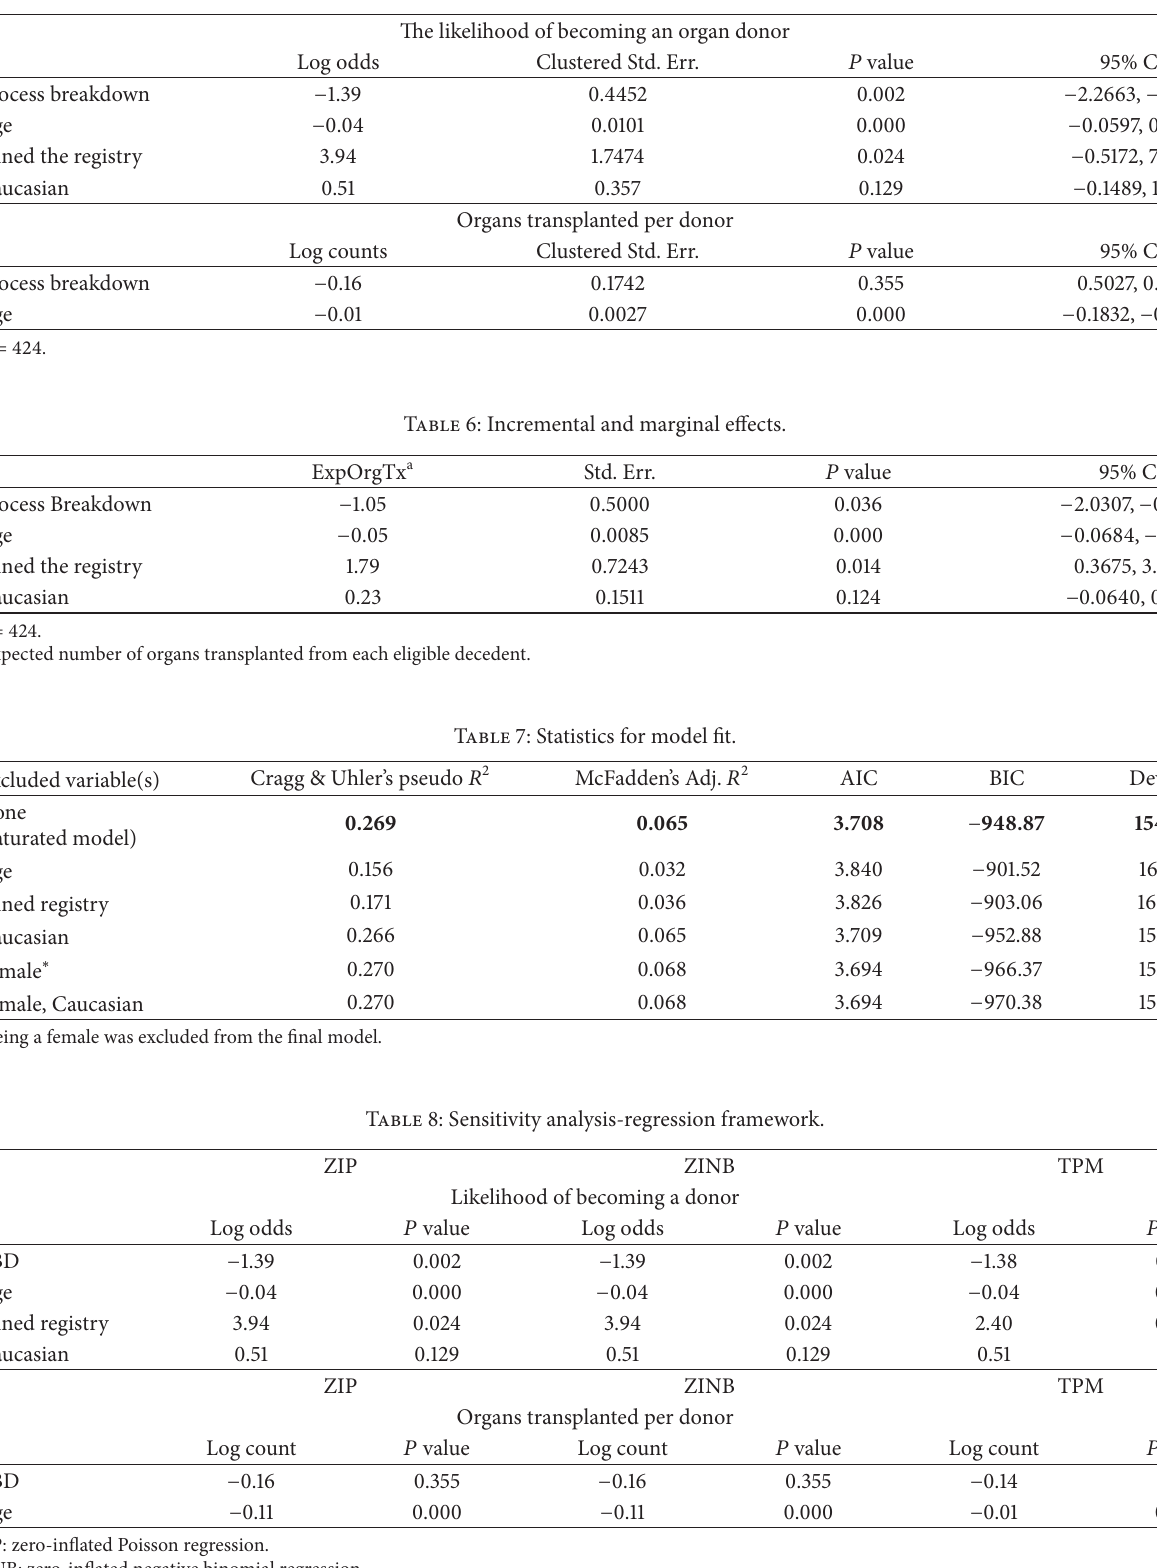
Table 5: Results from zero-inflated Poisson regression.